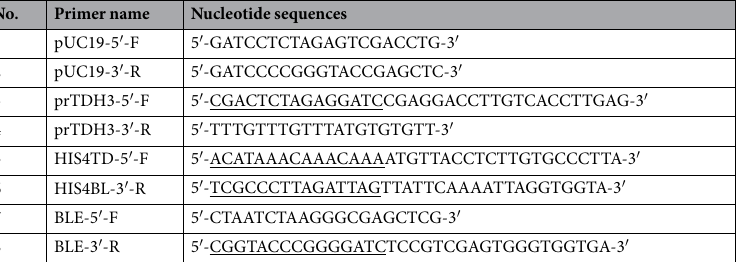
Table 1. Primers used in this study. Underline indicates additional hanging 15 nucleotides for In-fusion